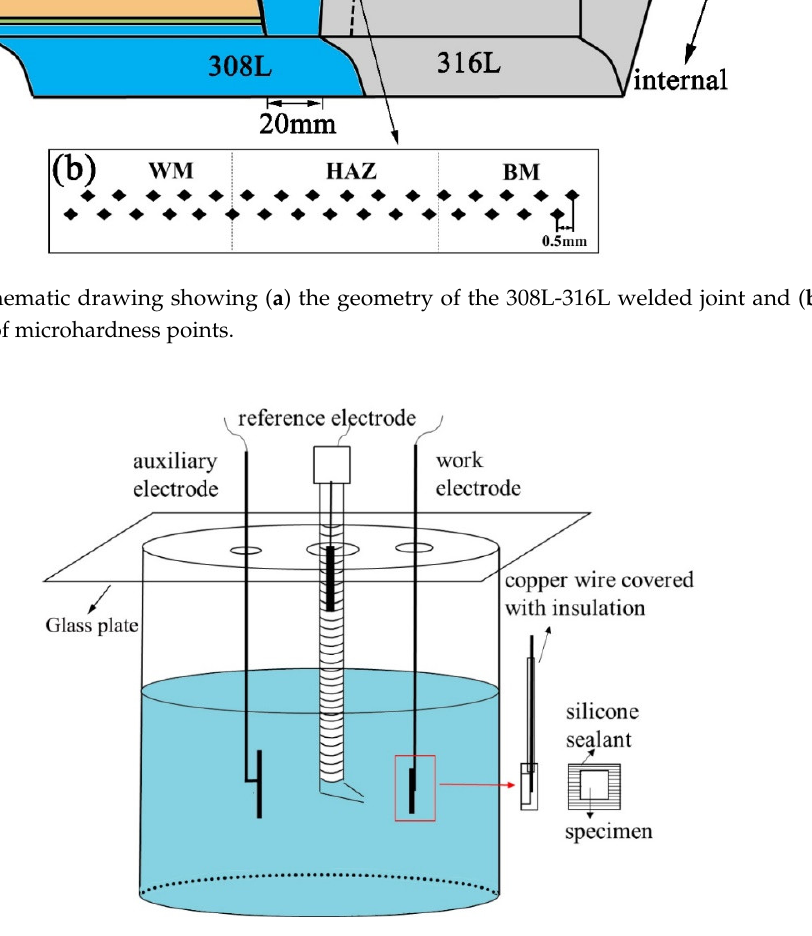
Figure 2. Schematic drawing of the electrochemical cells.